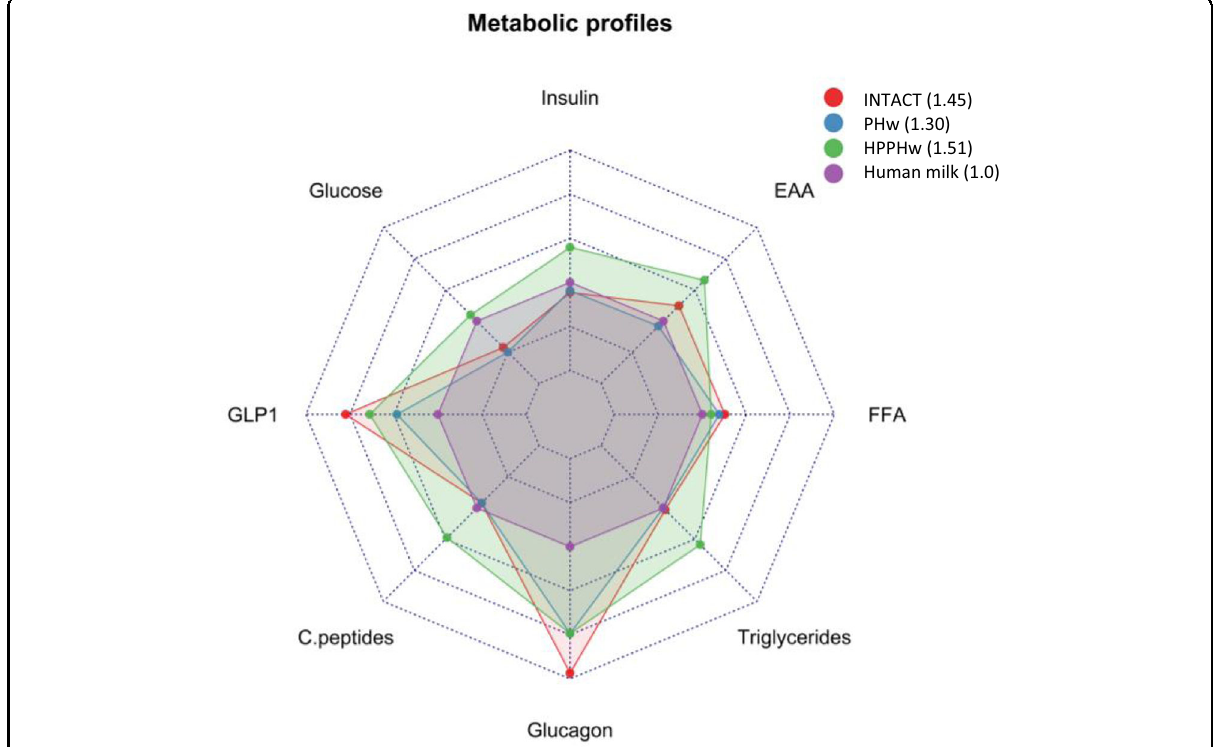
Fig. 4 Metabolic pro fi les of the infant formulas with respect to human milk (HM) based on iAUC (and negative AUC for free-fatty acids only). Red: INTACT ( n = 29), intact protein formula; Blue: PHw ( n = 29), partially hydrolyzed whey protein formula; Green: HPPHW ( n = 28), higher protein PHw formula; Violet: Human milk ( n = 8). The differences compared with HM were estimated by permutation tests. The scales of the radar plot range from 0 to 250%. The numbers in parentheses in the legend (1.45, 1.30, 1.51) indicate the average differences compared to HM, which is considered the reference as assigned a value of